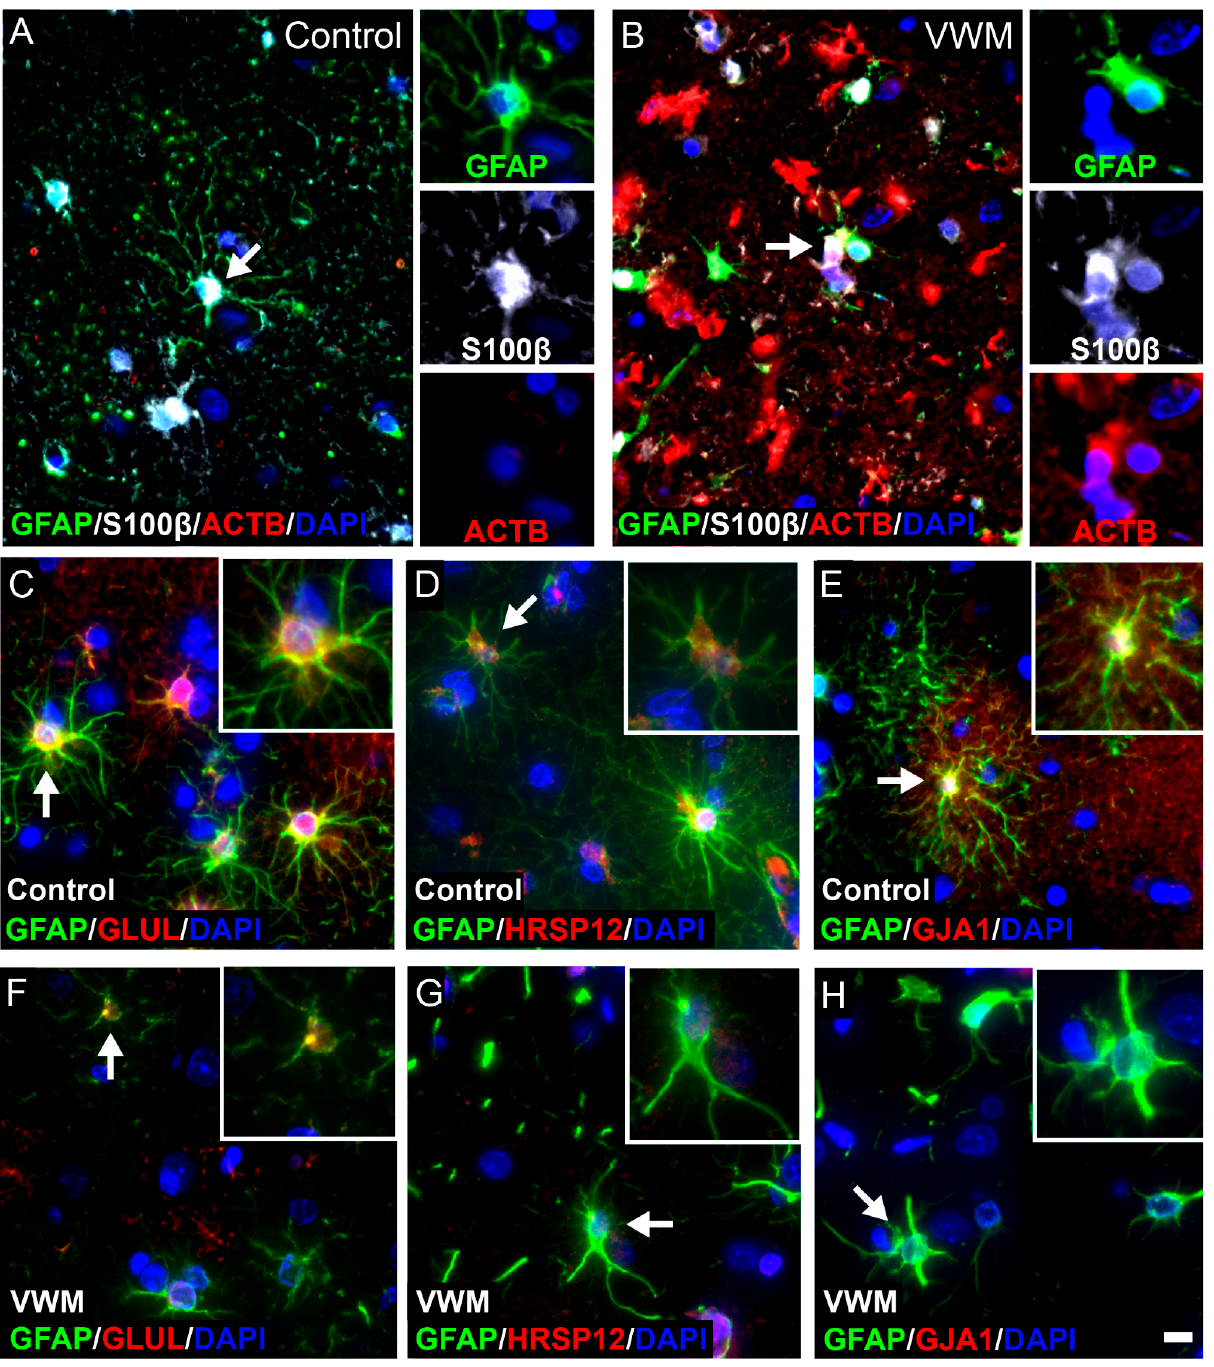
Figure 6. Cellular distribution of ACTB, GLUL, HRSP12 and GJA1 in control and VWM cortices. Triple stain against GFAP (green) and S100 β (white) with ACTB (red) in control ( A ) and VWM ( B ) cortices. Double stain against GFAP (green) with GLUL, HRSP12 and GJA1 (red) in control ( C – E ) and VWM ( F – H ) cortices. Cells indicated by white arrows are displayed in insets. Blue stain indicates nuclei. Scale bar: 10 µ m. Depicted images are stains of control 4 and VWM